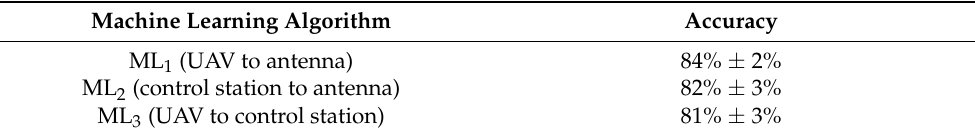
Table 1. Accuracy of the ML algorithms for 3 tests following 3-fold cross-validation.